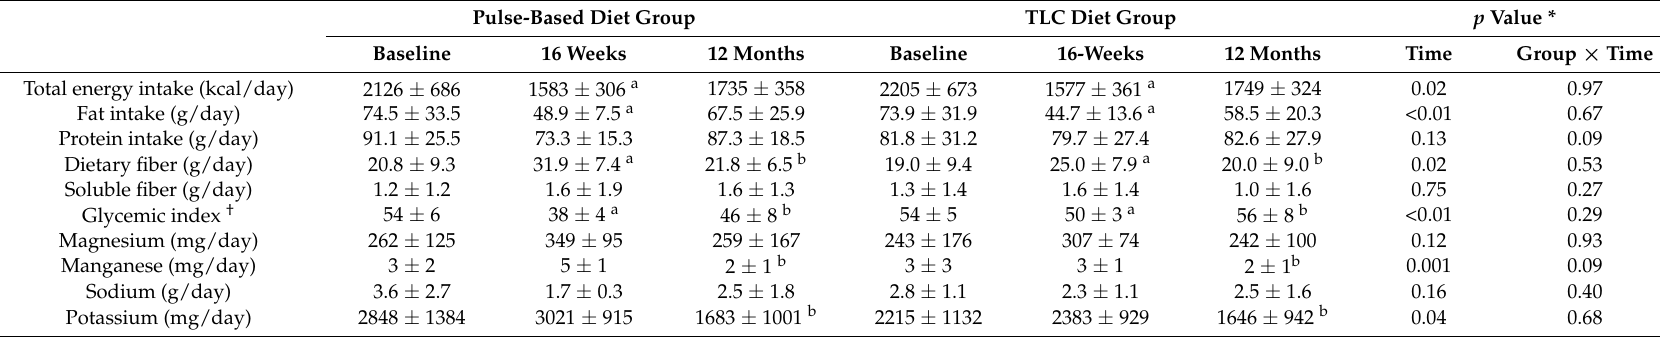
Table 7. Dietary intakes of women who completed the 12-month follow up phase of the study at baseline, 16 weeks, and 12 months